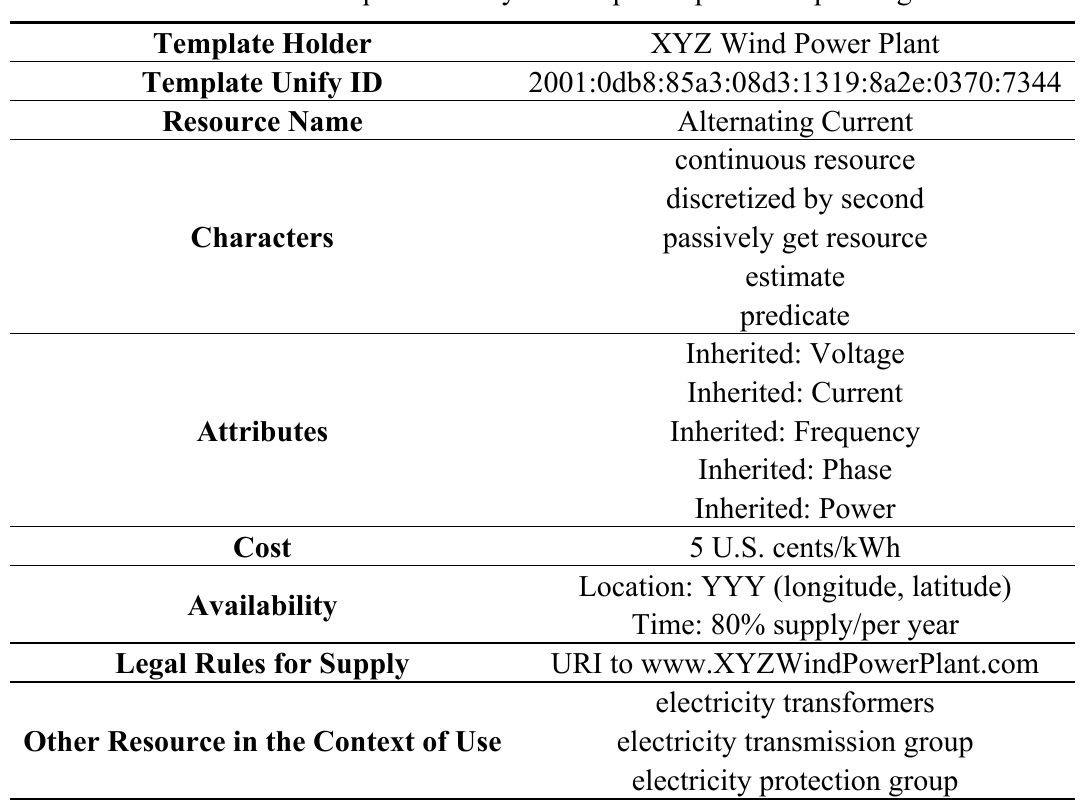
Table 2. RSDT published by a wind power plant in a power